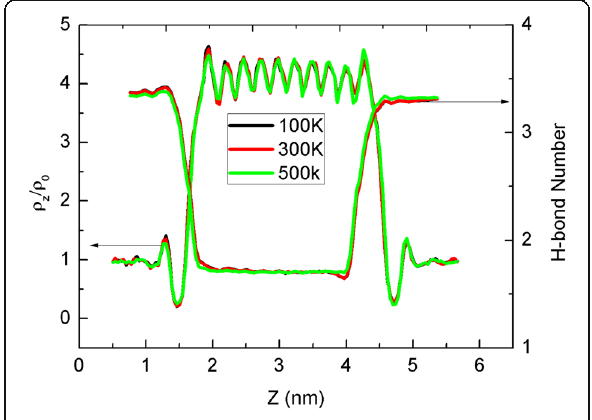
Fig. 4 Density and hydrogen bond number distribution along z axis and different line colors are for different sheet temperatures. Here, ρ 3 of the bulk water 0 is 1.0 g/cm